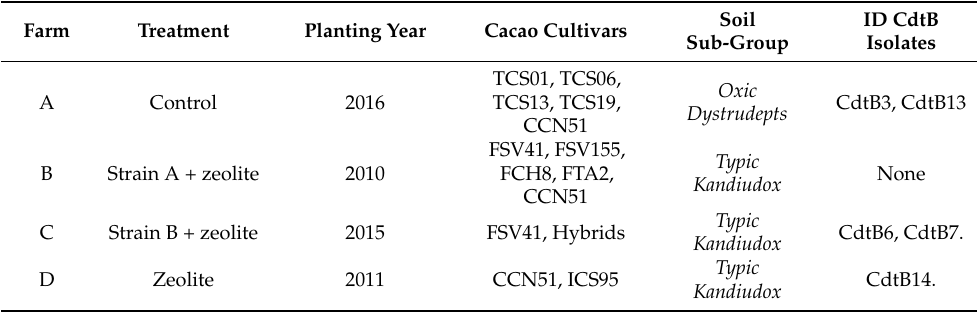
Table 1. Cocoa varieties sampled in each of the farms and ages of the plantations. The ID of the cadmium-tolerant bacteria (CdtB) isolates is related to the farm